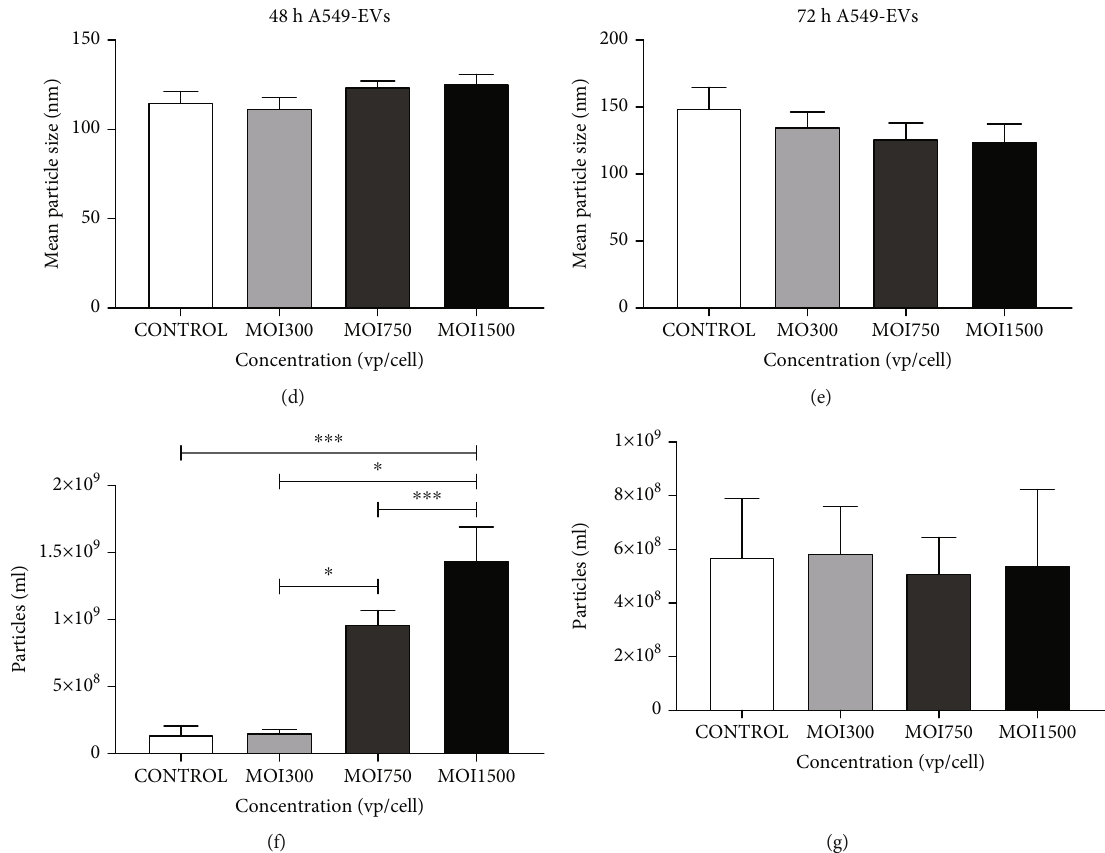
Figure 2: Morphological characterization of HAdV3-infected A549-derived exosomes. (a) TEM analysis of HAdV3-infected A549-derived exosomes. Images showing morphologies of EVs isolated from uninfected and MOI 300. (b) NTA showing distribution pattern of uninfected EVs (c) at MOI 300. (d) The graph showing assessment of EVs ’ mean particle sizes after 48h of infection and (e) 72h of infection. (f) The graph showing quanti fi cation of HAdV3-infected A549-derived EVs per mL after 48h and (g) 72 h of infection. Data show the mean ± SEM from four independent experiments. Data shows the mean ± SEM from four independent experiments and performed using one-way analysis of variance (ANOVA) with Tukey post hoc analysis. Statistical signi fi cance is indicated by the mean ± SD as follows: ∗ p < 0 : 05 , ∗∗ p < 0 : 01 , ∗∗∗ p < 0 : 001 , and ∗∗∗∗ p < 0 : 0001